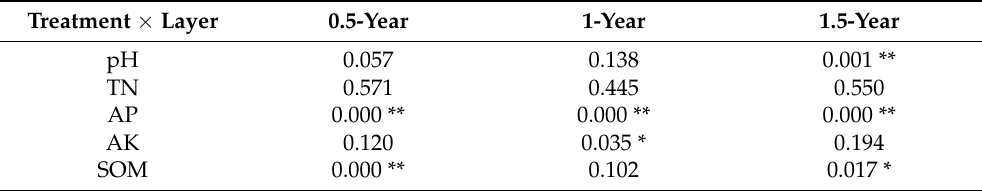
Table 3. Interaction of five fertilization types and two soil layers in soil nutrient content of Pinus tabuliformis . Treatment × Layer